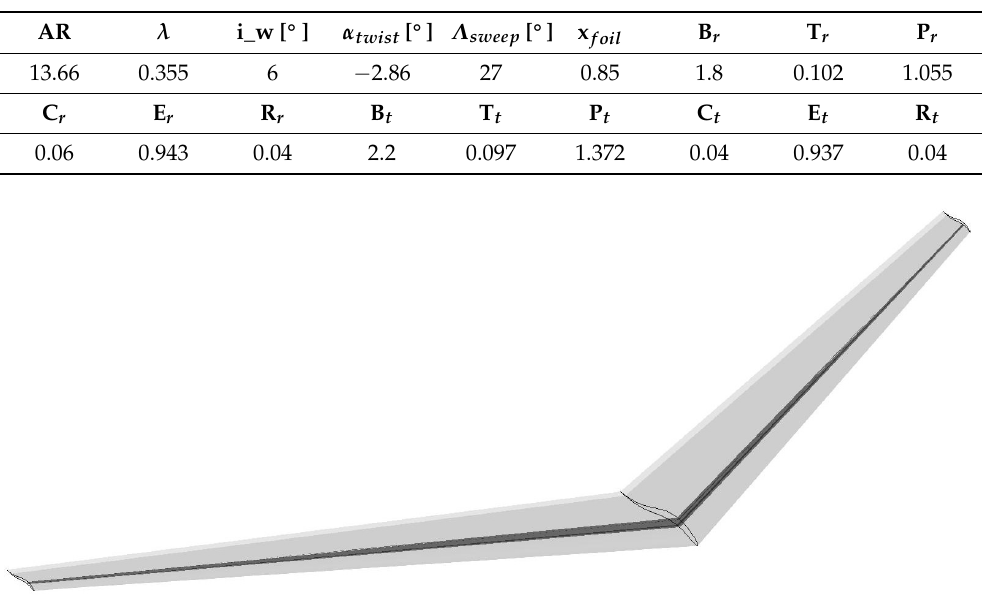
Figure 7. Optimal wing and beam for the case